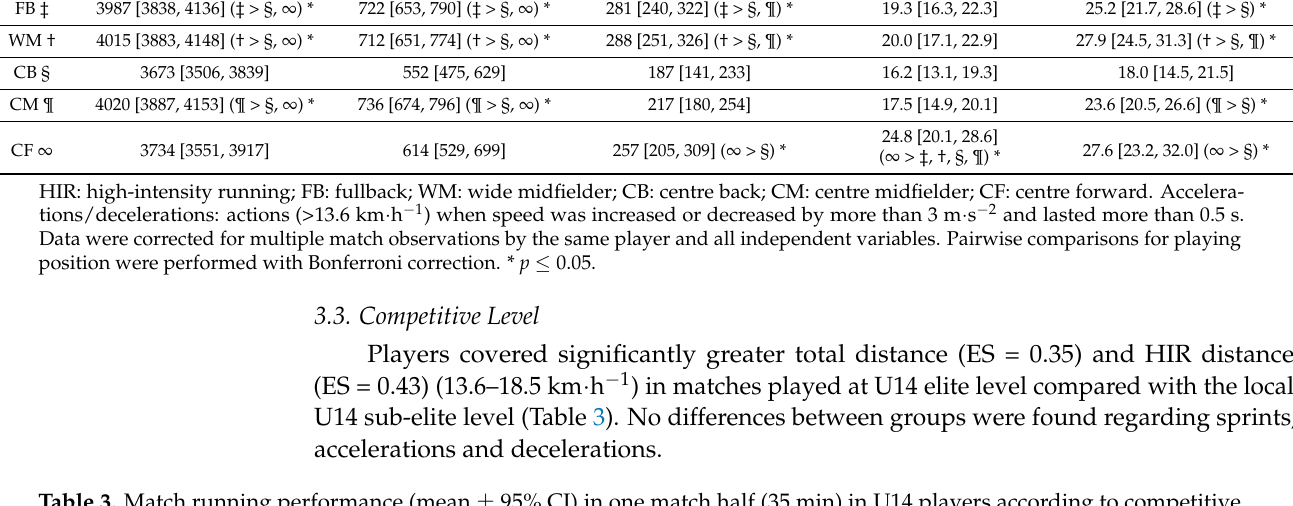
Table 3. Match running performance (mean ± 95% CI) in one match half (35 min) in U14 players according to competitive